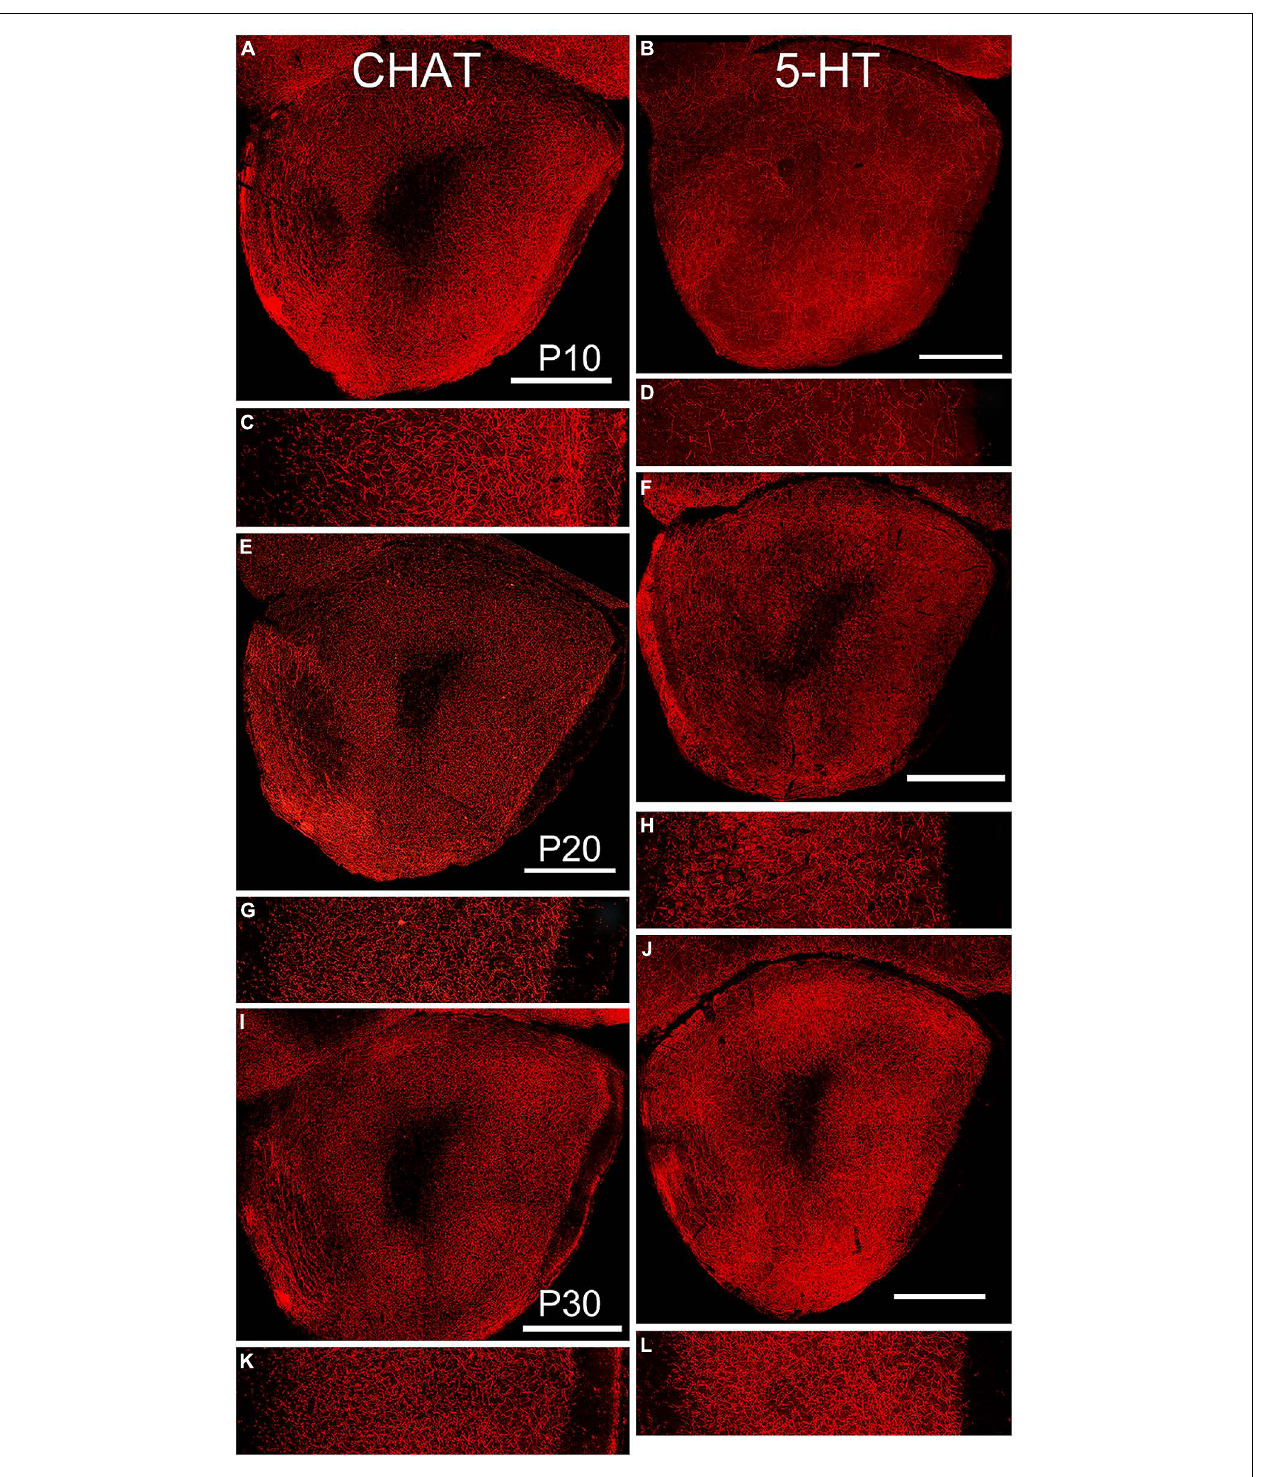
FIGURE 6 |Age-related changes in expression of markers for cholinergic (left column, CHAT), and serotonergic (right column, 5-HT) fibers. Paired low-power coronal images (taken at the same level as the diagram in Figure 1C ) and 350 μ m lateral strips in each column represent P10 (A , C and